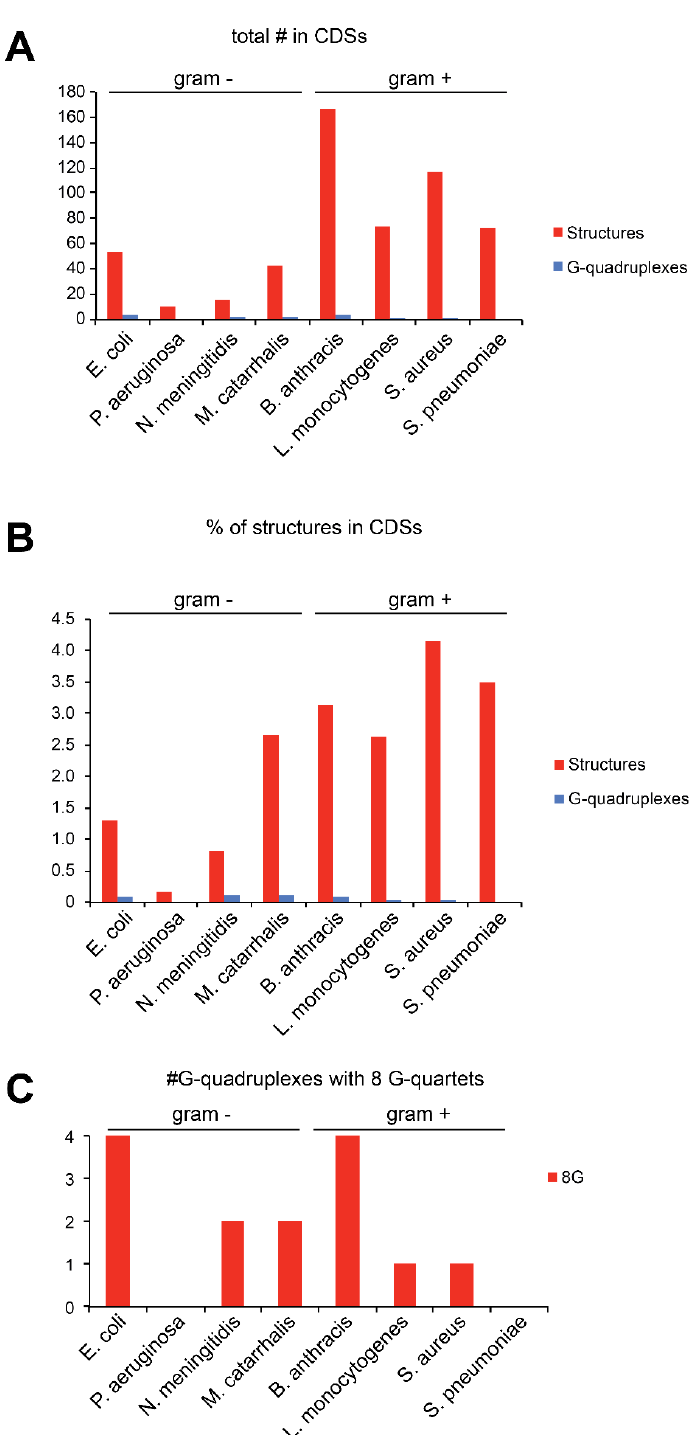
Figure 3. ( A ) The histogram represents the total number of putative secondary structures (red) and G-quadruplexes (blue) found in the + 16 to + 65 window of CDS that have a MFE struc / MFE rand ratio of at least 2 in the CDSs of eight bacteria. Four Gram-negative bacteria are shown on the left and four Gram-positive are shown on the right. ( B ) The histogram represents the percentage of CDSs that contained secondary putative structures (red) and G-quadruplexes (blue). ( C ) The histogram represents the number of G-quadruplexes with 8 G residues in each